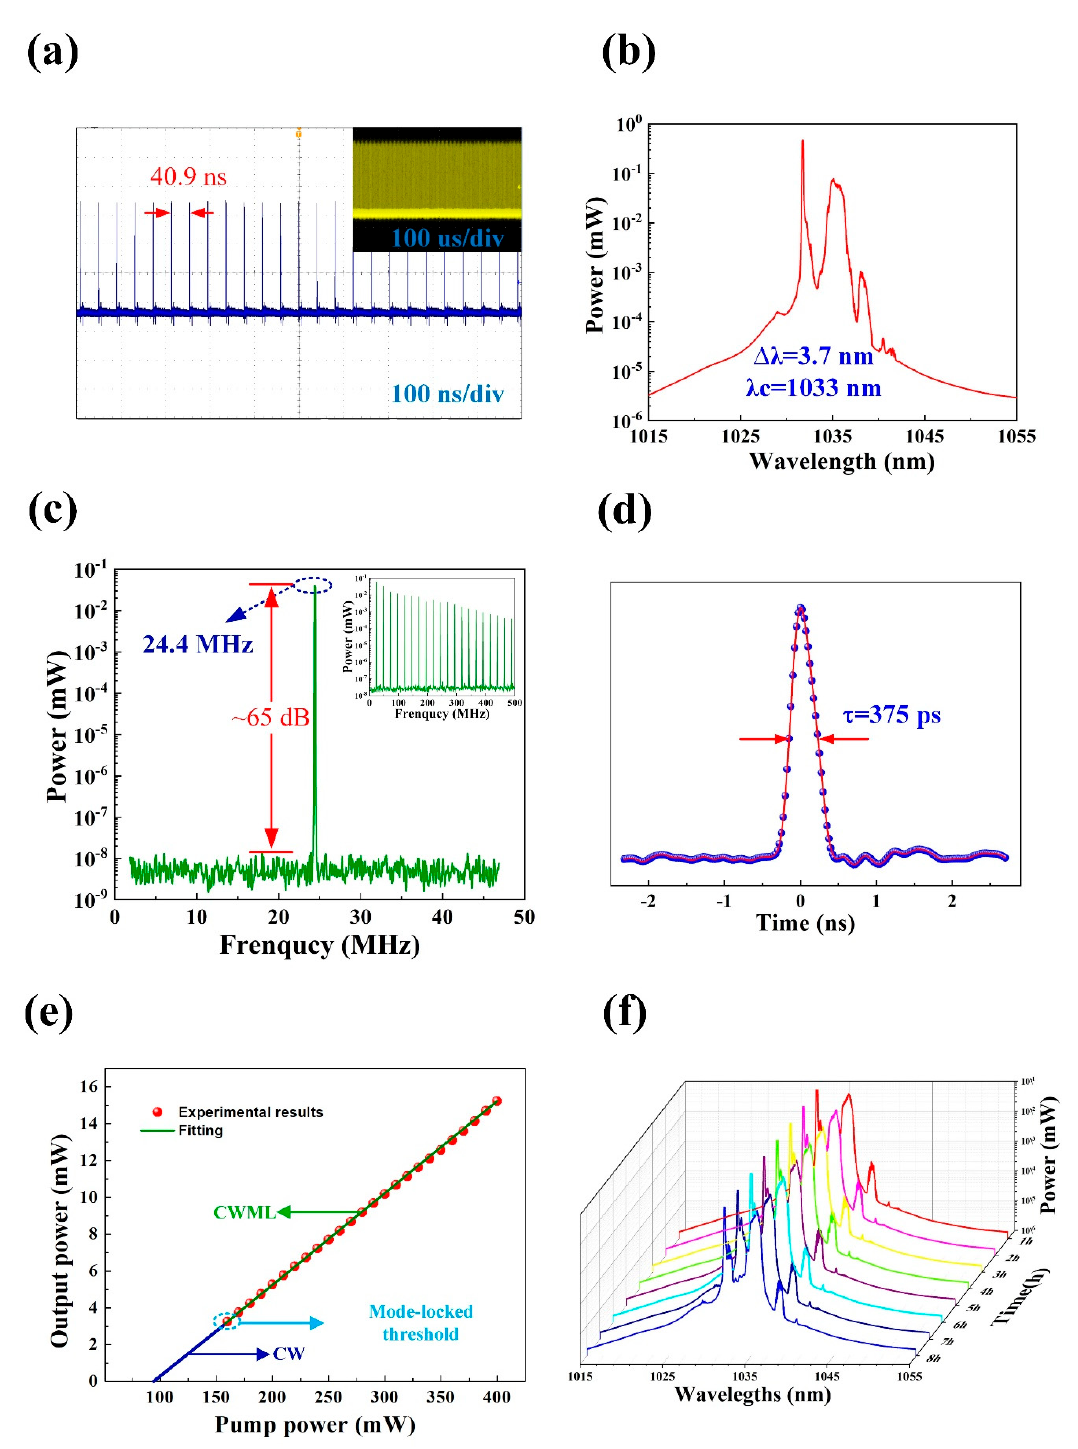
Figure 6. Typical mode-locked pulse characteristics. ( a ) Pulse train. ( b ) Optical spectrum. ( c ) Radio frequency spectrum (inset: the wideband RF spectrum) of the mode-locked pulses. ( d ) measurement of the laser pulse width. ( e ) Variation of the output power with respect to the pump power. ( f ) Optical spectra measurements at 1h intervals over 8 h of operation. Table 1. Various TMD-based SAs for mode-locking operation in Ytterbium-doped fiber laser system .